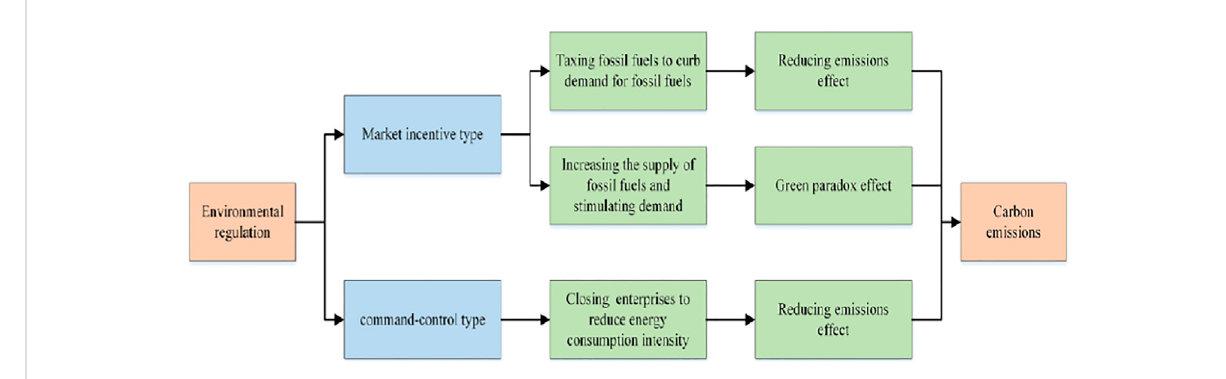
FIGURE 2 Direct functional path of environmental regulation on carbon (CO 2 ) emissions.